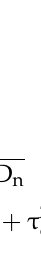
Figure 5. The simulated conduction band of a p-i-p photodetector shows how photogenerated minority charge carriers can be trapped and the cross-section of the p-i-p detector (inset).